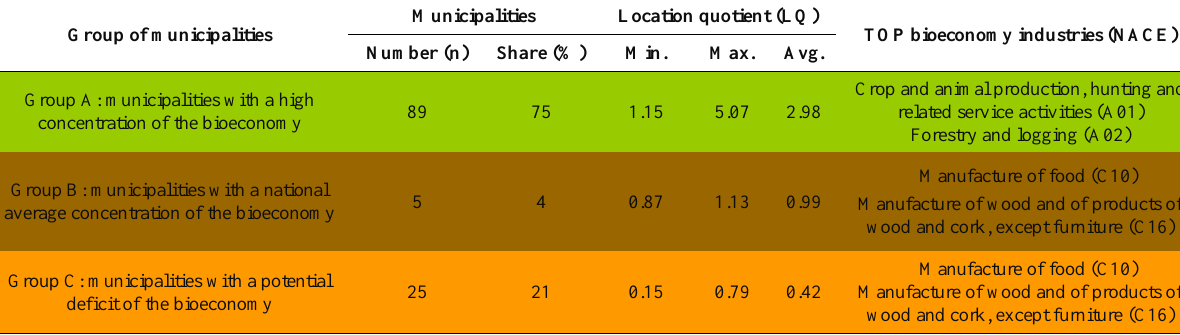
Figure 4. Spatial distribution of location quotients for the bioeconomy (LQ) in 2019 Table 2. Groups of municipalities with different bioeconomy concentration levels in